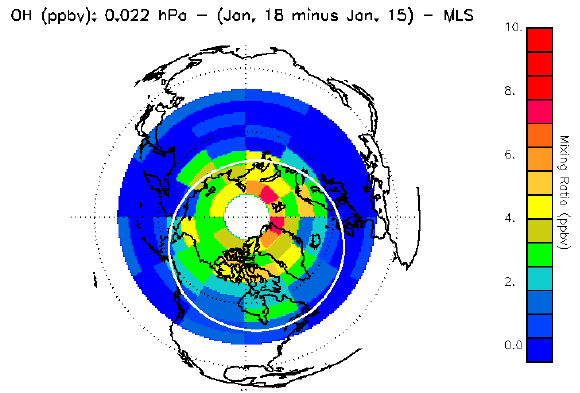
Fig. 3. Aura MLS OH measurements at 0.022hPa ( ∼ 75km) on 18 January 2005 (after SPE) minus those on 15 January 2005 (before SPE). For added clarity, measurements are only shown in the lat- itude range 42.5–82.5 ◦ N. No MLS measurements are available at 82.5–90 ◦ N. The polar cap edge (60 ◦ geomagnetic latitude) is indi- cated by the white circle.